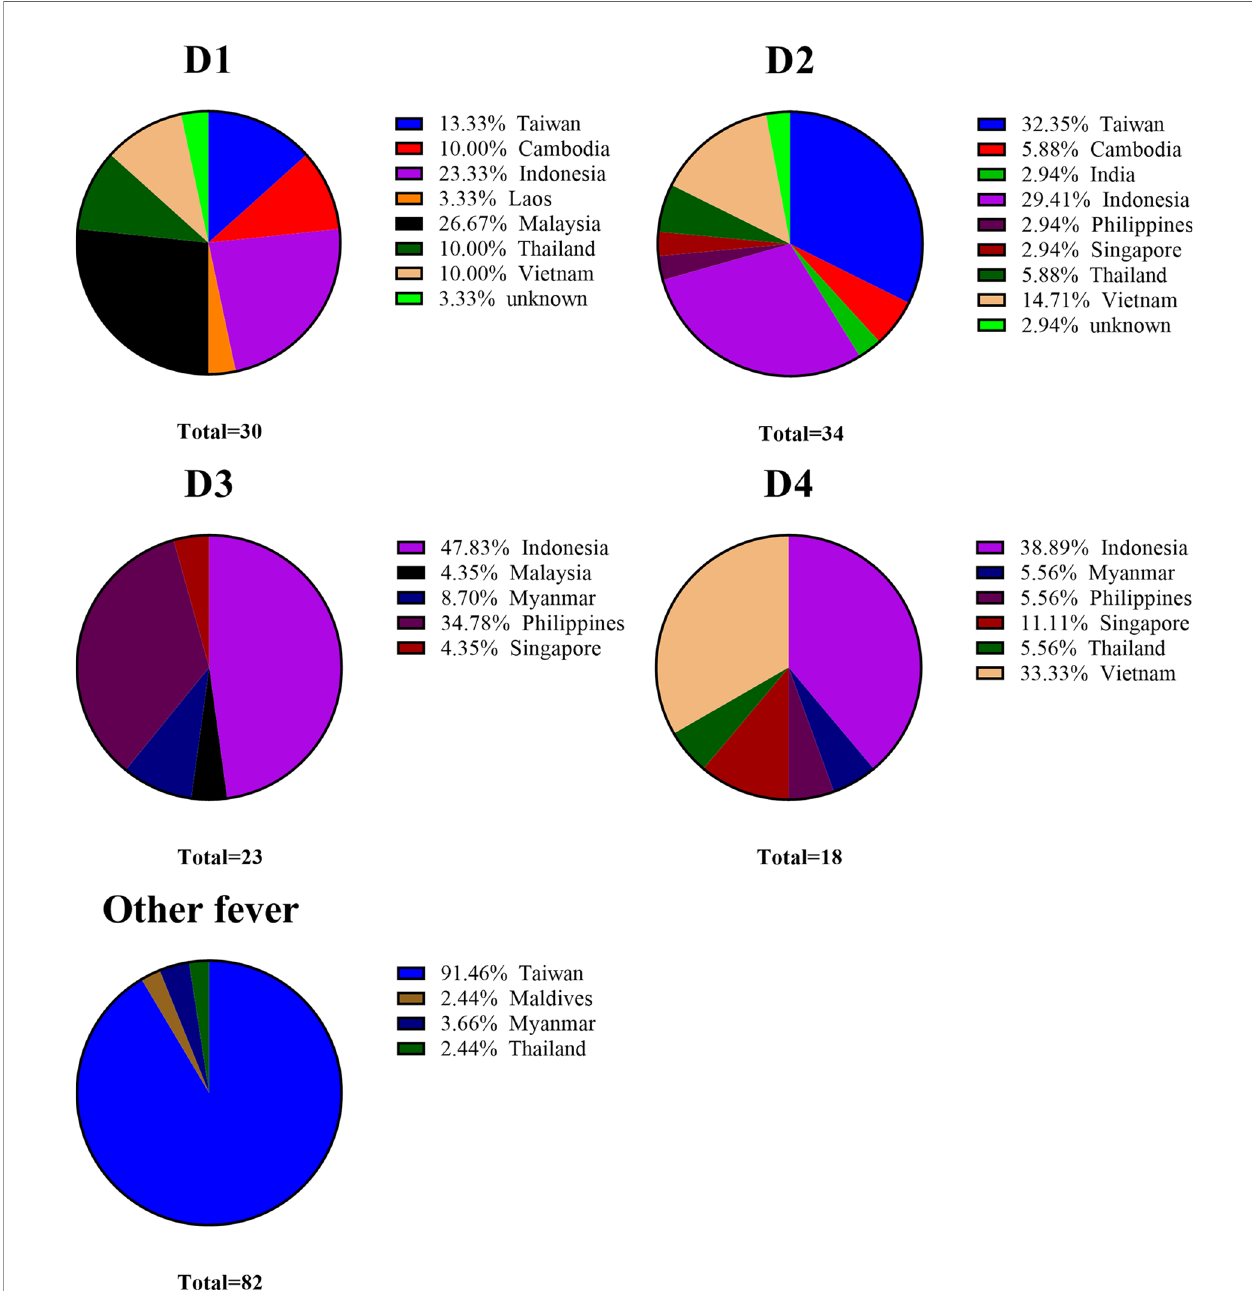
FIGURE 3 | Distribution of DENV and other fever clinical serum samples collected from different